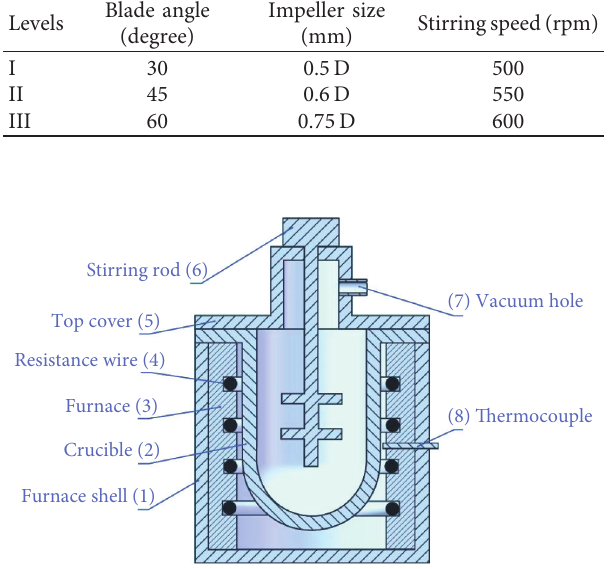
Figure 14: Sketch of the experiment equipment